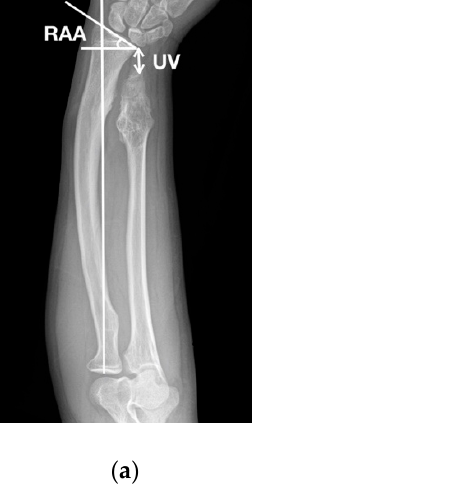
Figure 1. Masada classification [11] . Type I : The osteochondromas mainly occur at the distal ulna. The ulna is relatively shortened, and usually accompanied by radial bowing deformity. Type IIa : The radial head is dislocated with osteochondroma formation at the proximal radius. Type IIb : The radial head is dislocated without osteochondroma formation at the proximal radius. Type III : The radius is relatively shortened, and the osteochondroma forms at the distal radius.